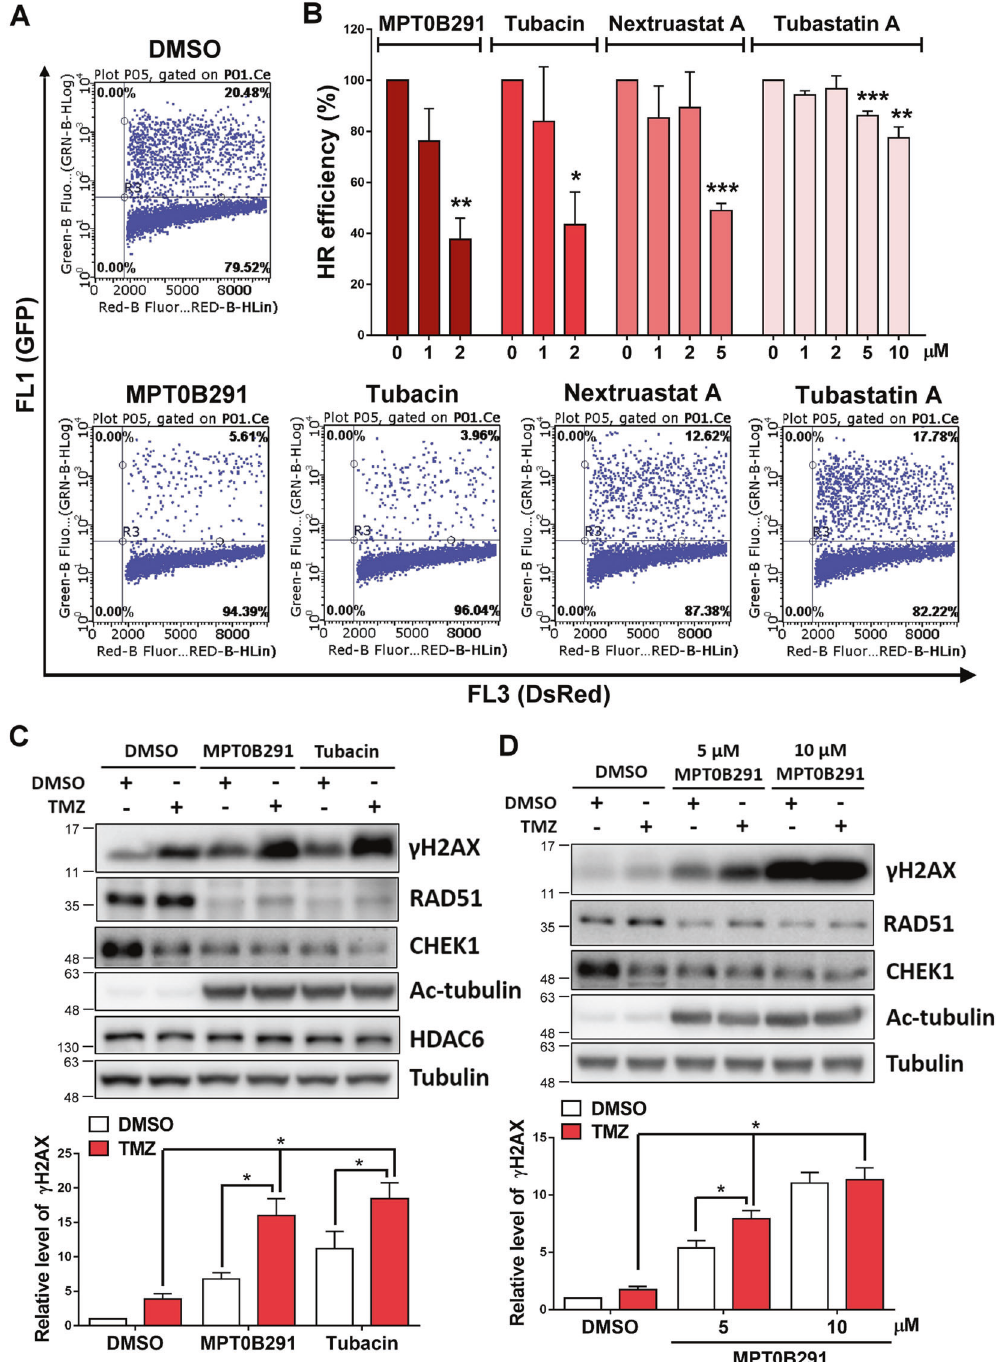
Fig. 3 Inhibition of HDAC6 enhances TMZ-induced DNA damage response. A, B HR assay was performed after the treatment with DMSO or each HDAC6 inhibitor for 48 h at 2 μ M in A and at indicated doses in B . Percentage of HR ef fi ciency was calculated as the ratio of the indicated dosage of HDAC6 inhibitor treatment to DMSO treatment and quanti fi ed after three independent experiments. C U87MG cells were treated with 5 μ M MPT0B291 or tubacin in the presence (100 μ M) or absence of TMZ for 24 h. D A172 cells were treated with the indicated concentrations of MPT0B291 in the presence (100 μ M) or absence of TMZ for 24 h. The protein levels of γ H2AX, RAD51, CHEK1, HDAC6, Ac- tubulin, and tubulin were analyzed by western blotting (upper panels). Quantitative results (normalized to tubulin) of γ H2AX from three independent experiments are shown (lower cells (Fig. 4D). Activation of the DDR signal could be detected in the MPT0B291-treated group (Fig. 4E). These results indicate that HDAC6 is an attractive therapeutic target in brain tumors.